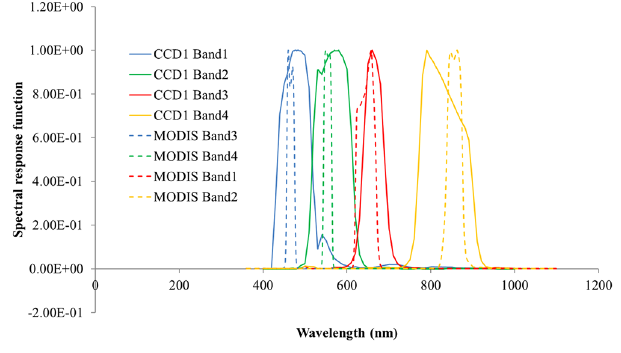
Figure 1. The spectral response function of HJ-1A CCD1 and Terra